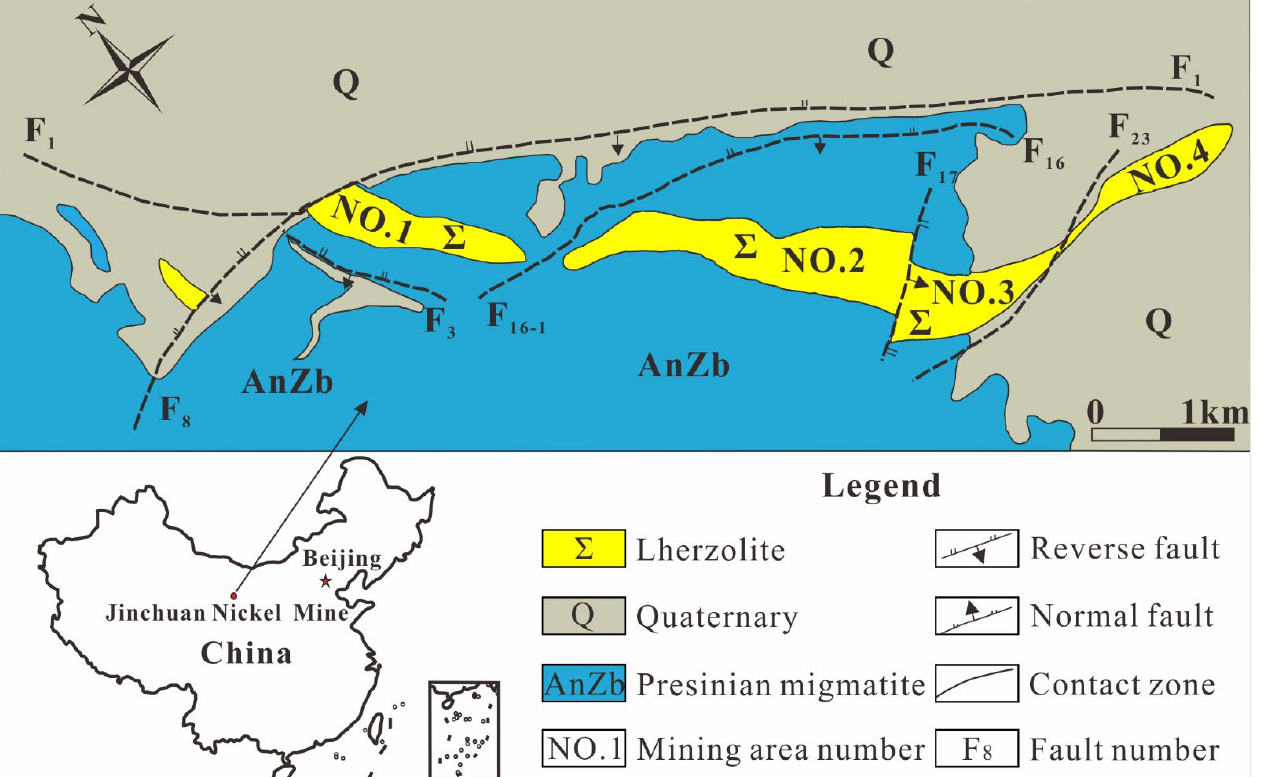
Figure 1. Engineering geologic map of Jinchuan Mine.